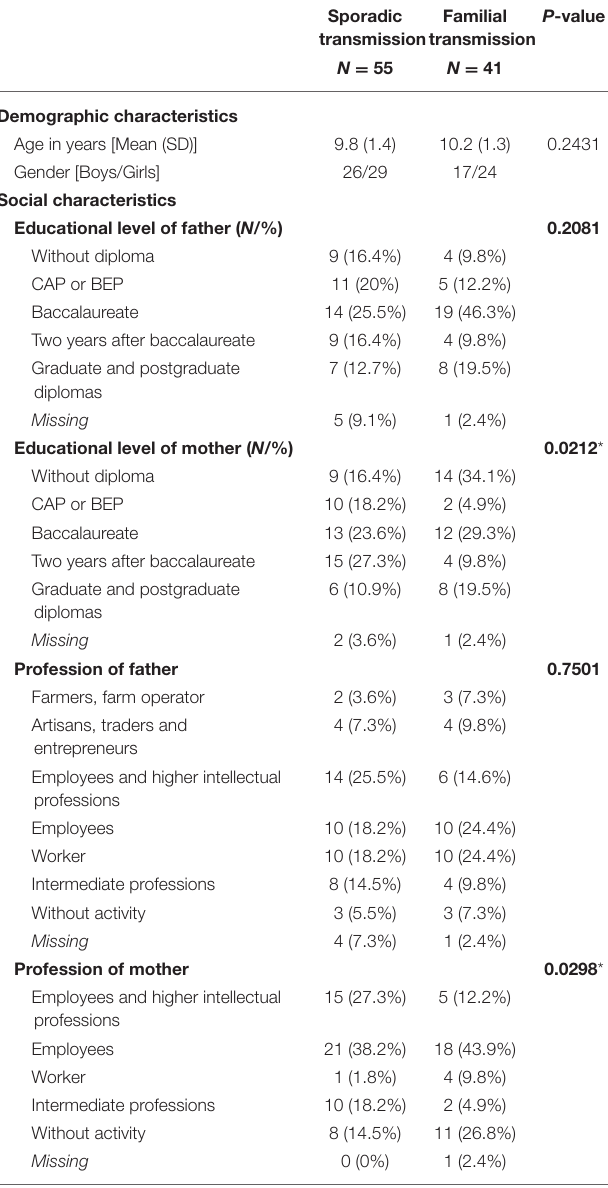
TABLE 1 | Demographic and Social Characteristics of the Sporadic and Familial